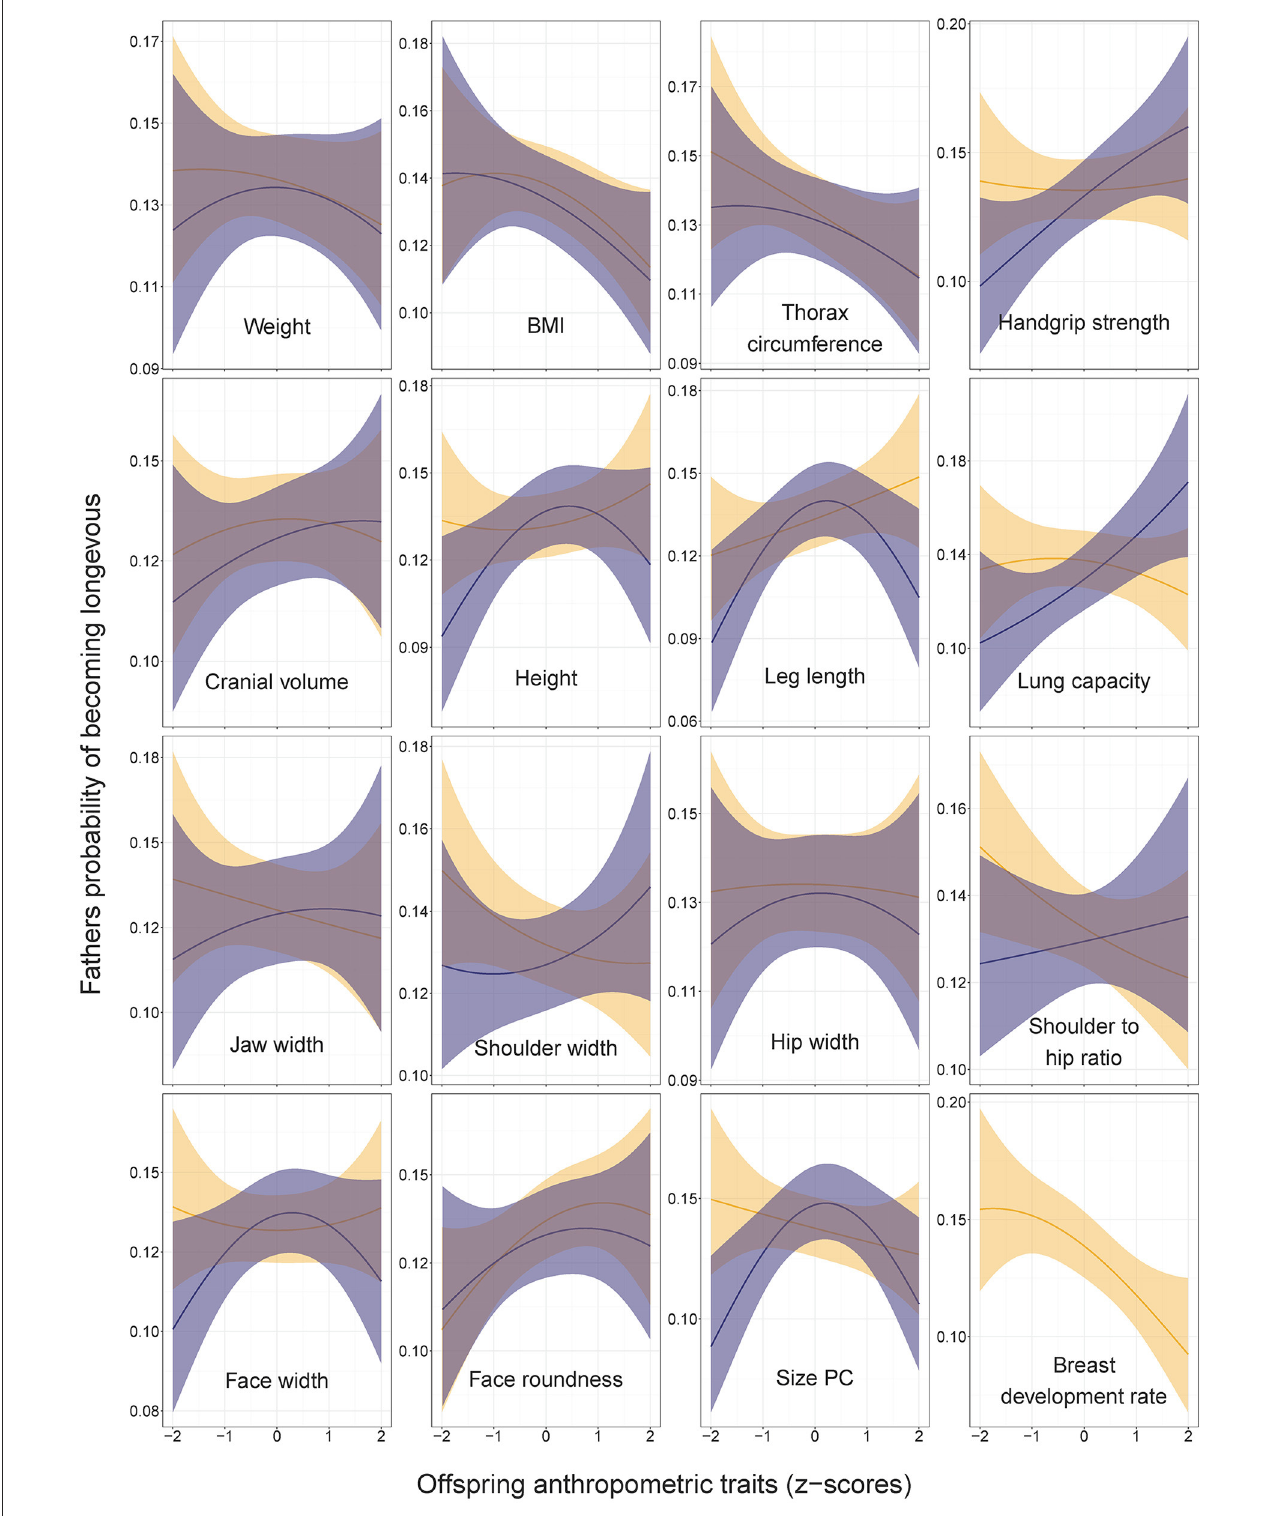
FIGURE4 Fathers’ probabilities of becoming longevous in relation to anthropometric traits of their sons (dark shading) and daughters (light shading). Predictions (with 95% CI) from the models without covariates: lrm[formula = longevity ∼ focal_trait + (focal_trait*focal_trait)]. Statistics are provided in Supplementary Table 1 in